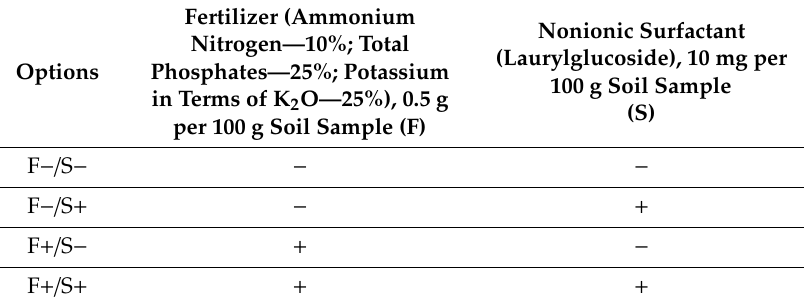
Table 1. Remediation options for petroleum-contaminated soil.